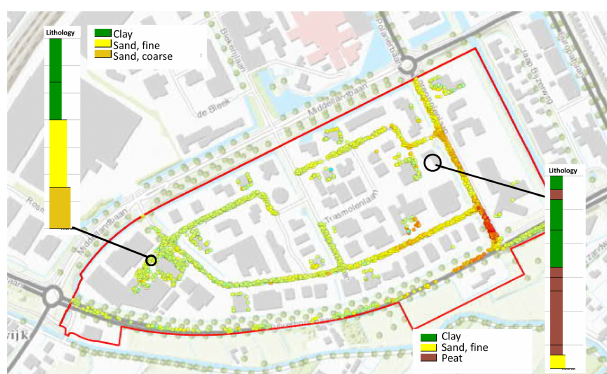
Figure 5. Difference of autonomous subsidence due to the different soil stratigraphy. For the meaning of the colours of the pixels see Fig. 4. Includes material ©2019 SkyGeo Netherlands BV. All rights